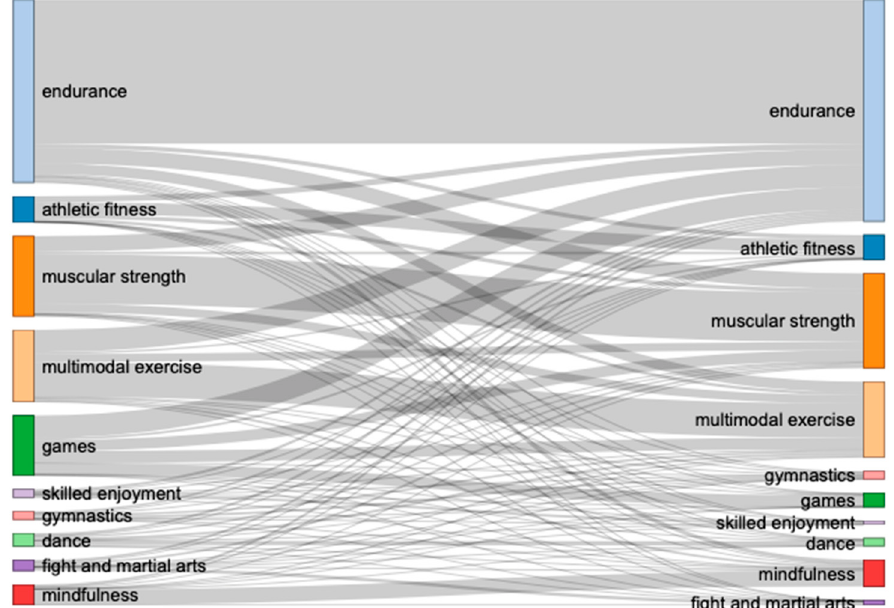
Figure 4. Changes in type of exercise (focus on specific category) for continuous exercisers. Note that ‘before COVID ‐ 19’ is depicted on the left and ‘during the initial COVID ‐ 19 lockdown’ on the right side.